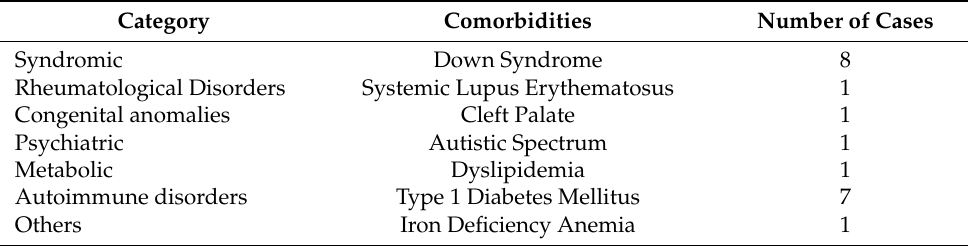
Table 4. Comorbidities associated with acquired